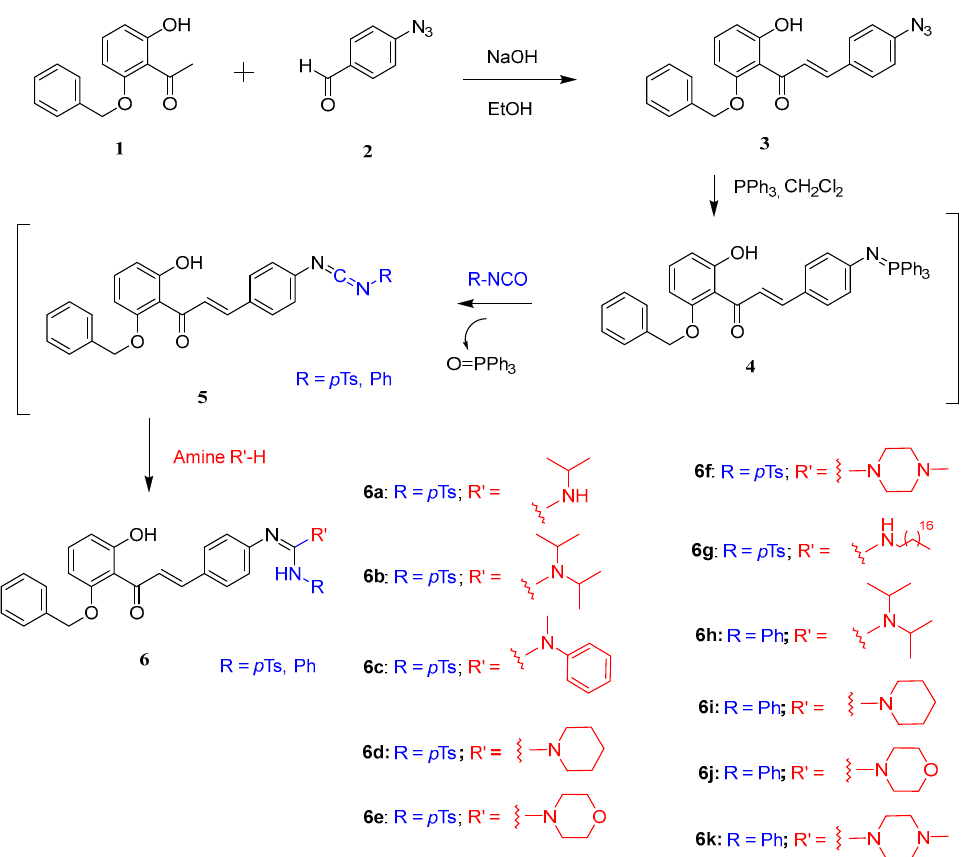
Table 2. Effects on cell viability of hybrid compounds on human cancer